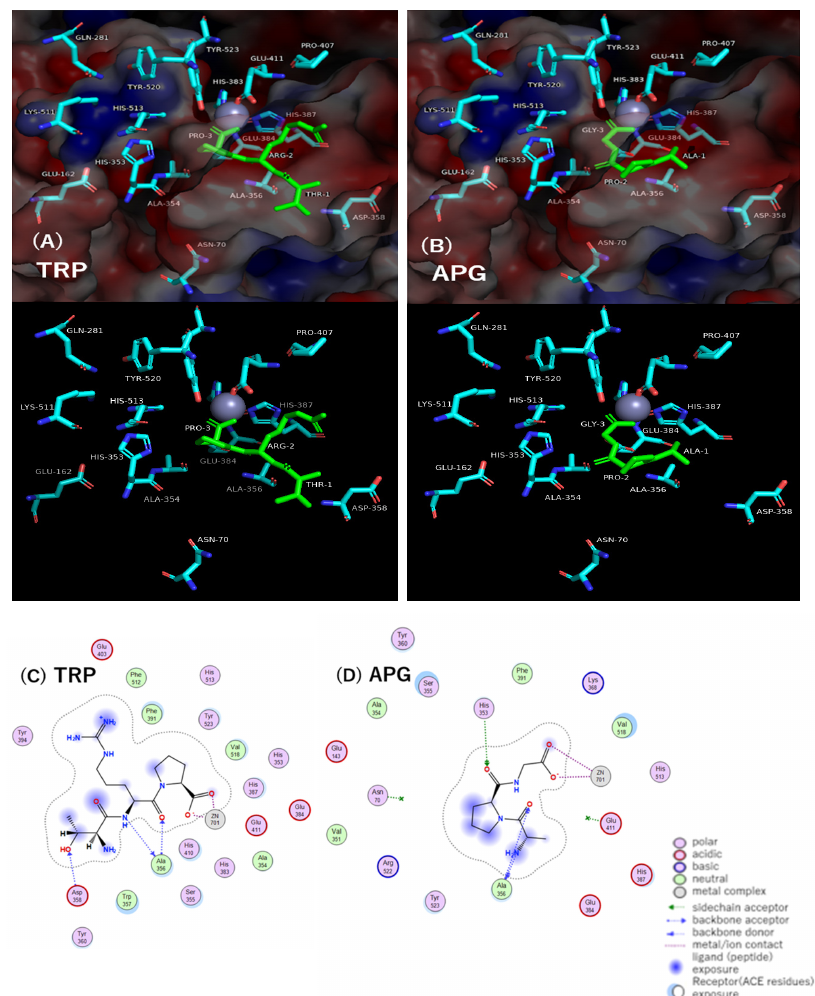
The symbols for each interaction are as follows. ✓ : Hydrogen bond interaction, ◎ : Ionic bond interaction, ○ : Metal/ion contact, * : Residue coordinated with Zn(II)701 in the ACE active pocket.